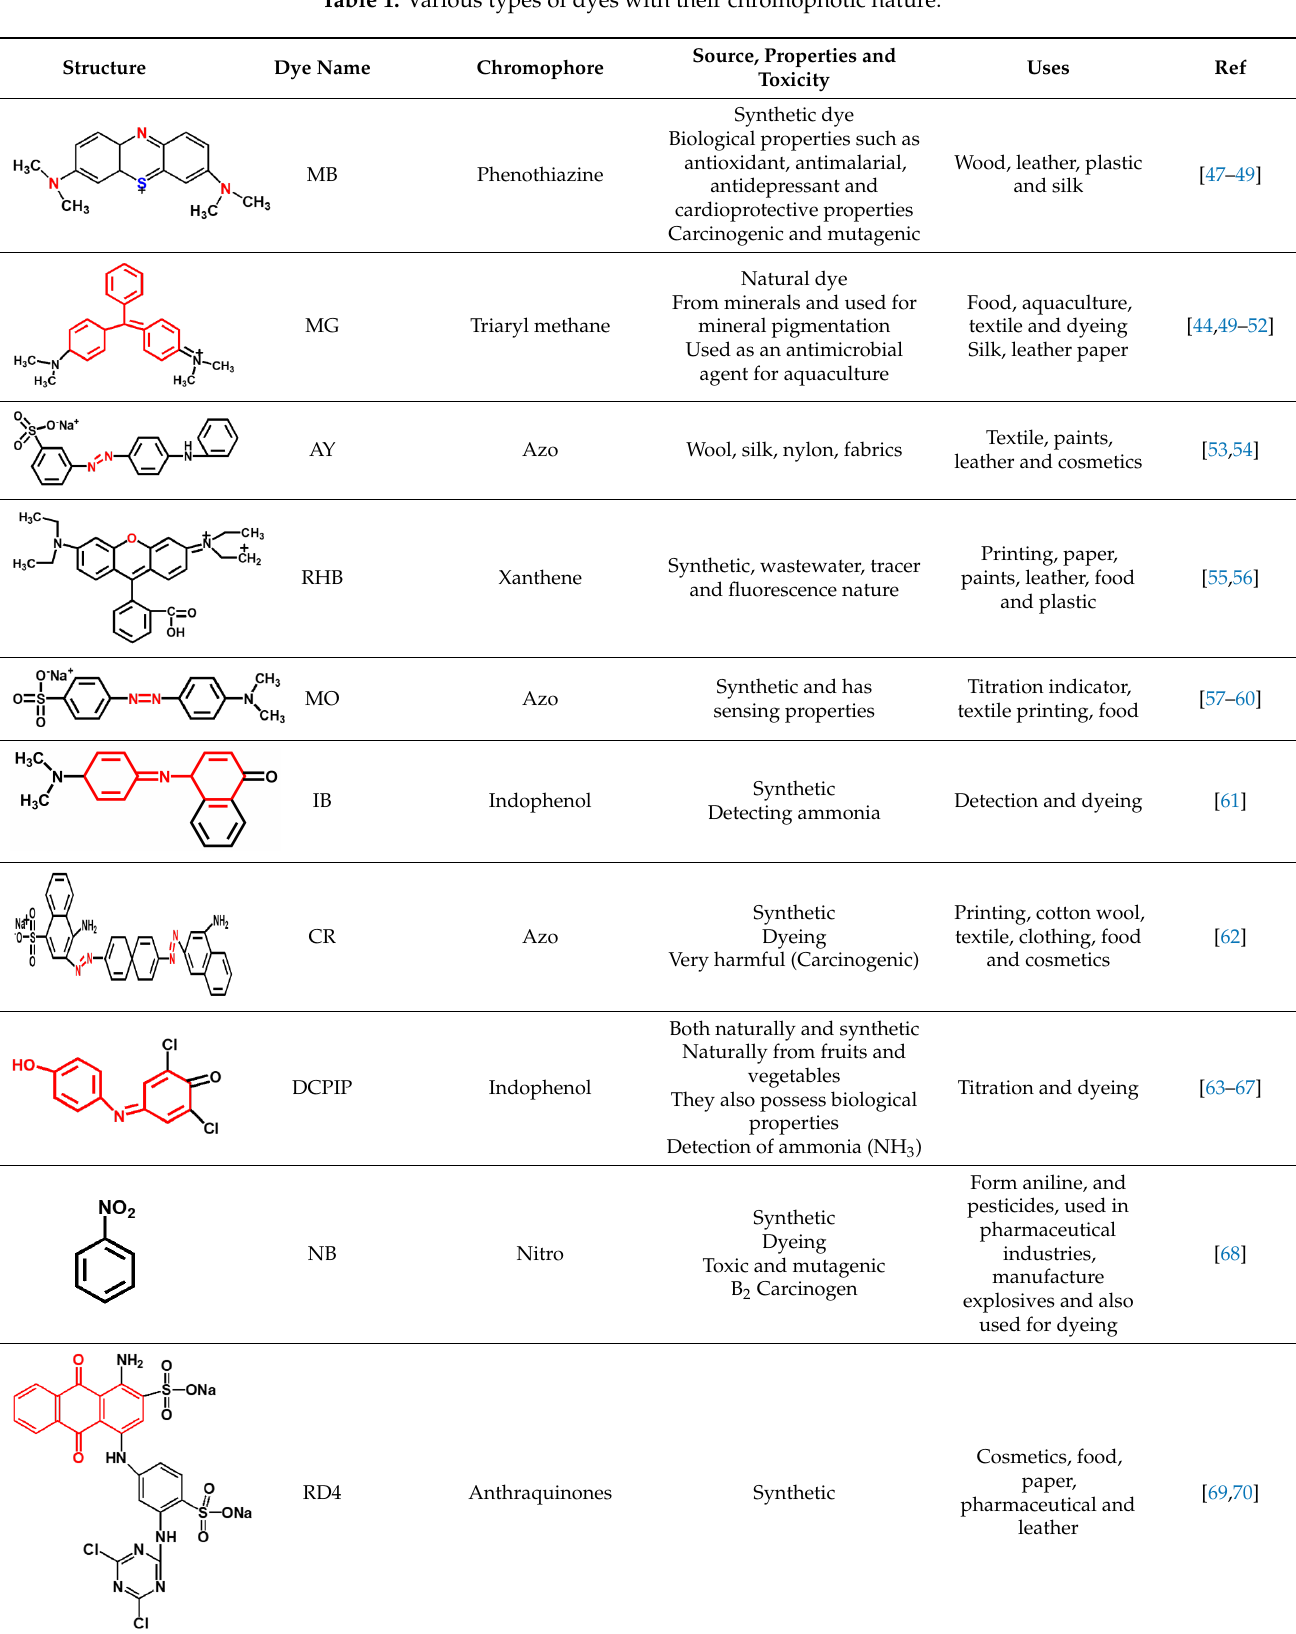
Table 1. Various types of dyes with their chromophotic nature. Structure